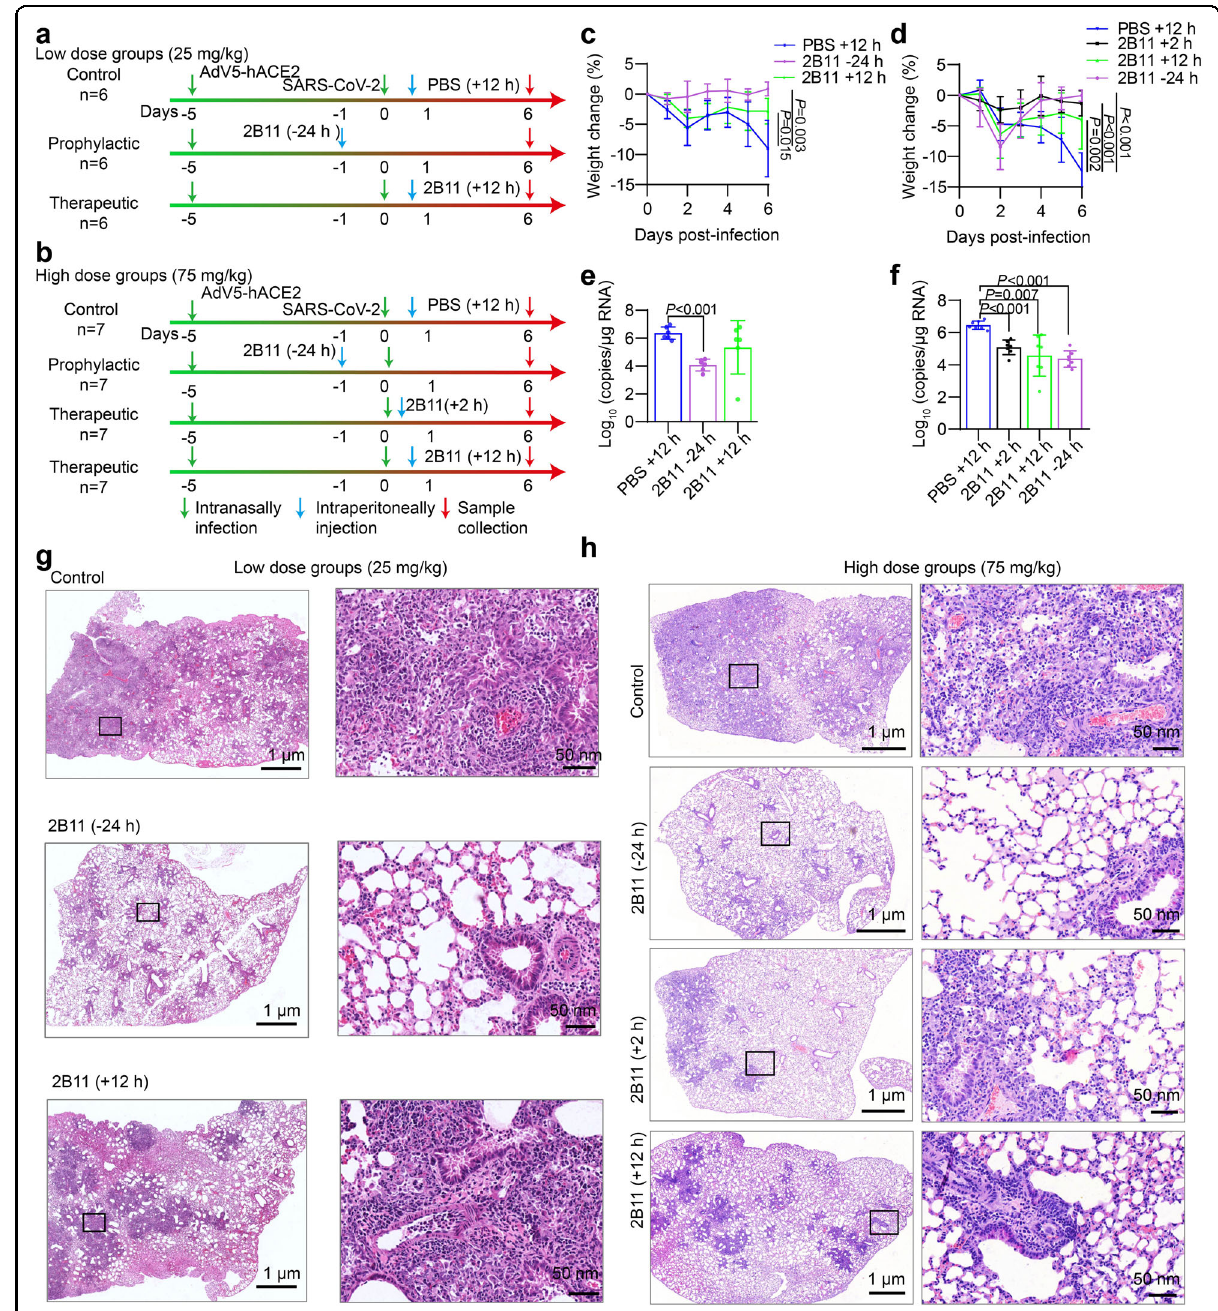
Fig. 7 The mAb 2B11 shows therapeutic and prophylactic potential in SARS-CoV-2-infected AdV5-hACE2-transduced mice. a , b The experimental design. Two independent experiments were performed. a In the low-dose experiment, mice were intraperitoneally injected with 25 mg/kg of 2B11 24 h before ( – 24 h) or at 12 h after ( + 12 h) SARS-CoV-2 infection; control mice were injected with 200 μ L PBS at + 12 h ( n = 6 per group). b In the high-dose experiment, the mice were treated with PBS 2 h after or 75 mg/kg of 2B11 24 h prior, or 2 h, or 12 h after infection ( n = 7 per group). c , d The body weight changes in the low- ( c ) and high-dose ( d ) 2B11-treated hACE2-transduced mice challenged with SARS-CoV-2 were recorded over 6 days. e , f The viral RNA levels in the lung tissues of the low- ( e ) and high-dose ( f ) 2B11-treated mice, were determined using qRT-PCR at 6 days post infection. Data are represented as the mean ± SD. Statistical signi fi cance was determined using the two-tailed Student ’ s t- test; P values are represented (of note, the P value between PBS + 12 h and 2B11 + 12 h in e is 0.233). g , h Histopathological analyses of 2B11-treated or untreated mice infected with SARS-CoV-2. Representative images of lung sections stained with hematoxylin and eosin in the context of low-dose ( g ) and high- dose ( h ) experiments (6 days post